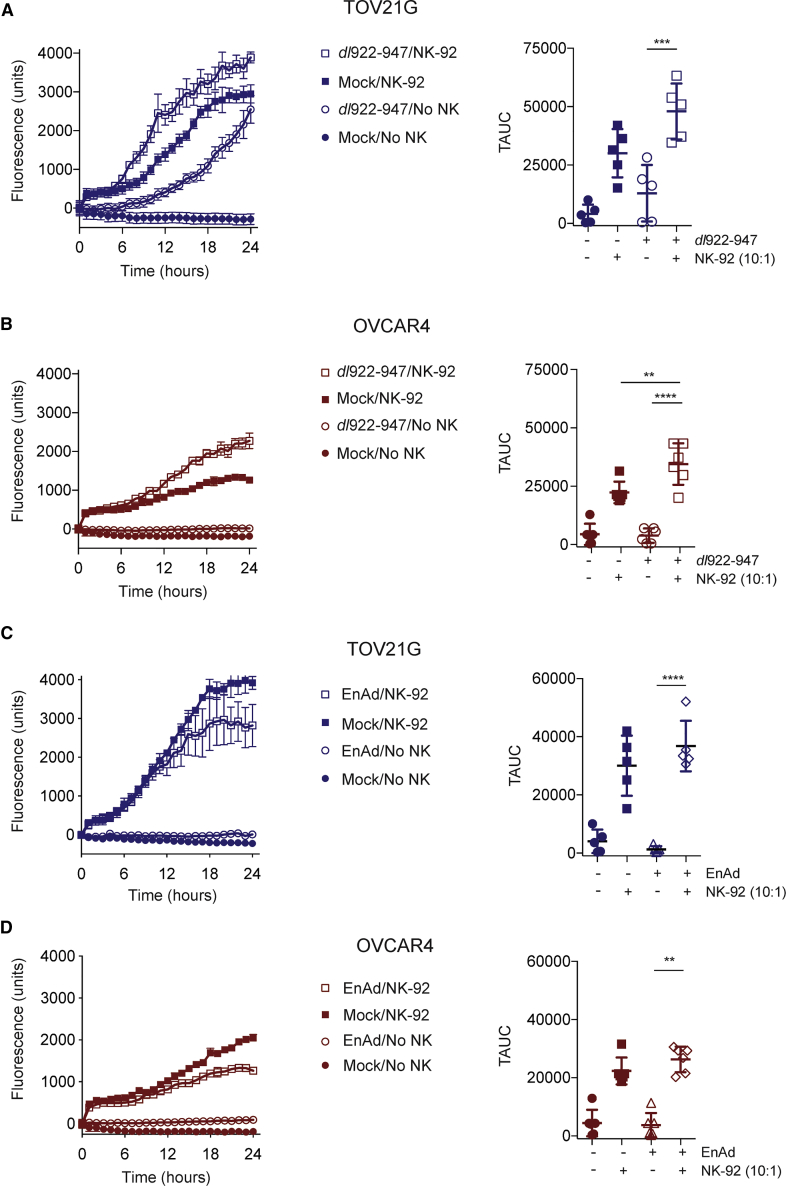
NK-92 Cells Increase Cytotoxicity of Oncolytic AdenovirusNK-92 cytotoxicity against TOV21G and OVCAR4 infected with dl922-947 (MOI 10, 48 h) or enadenotucirev (MOI 100, 48 h) was assessed by time-lapse microscopy. Fluorescent counts over time from individual experiments (left) and summary data (right) are presented: (A) TOV21G + dl922-947 (n = 5). (B) OVCAR4 + dl922-947 (n = 6). (C) TOV21G + enadenotucirev (n = 5). (D) OVCAR4 + enadenotucirev (n = 6). Summary data are expressed as total area under curve (TAUC) of fluorescent object counts over time (one-way ANOVA with multiple comparisons test).